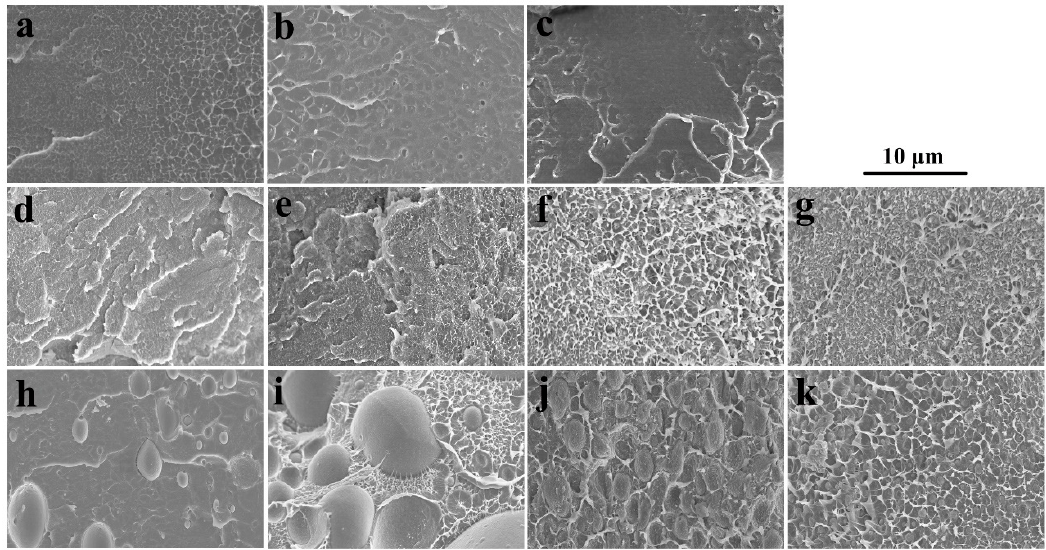
Figure 2. SEM images of ( a ) SPEEK44, ( b ) SPEEK73, ( c ) PVDF, ( d ) SPEEK44/PVDF-10, ( e ) SPEEK44/PVDF-30, ( f ) SPEEK44/PVDF-50, ( g ) SPEEK44/PVDF-80, ( h ) SPEEK73/PVDF-10, ( i ) SPEEK73/PVDF-30, ( j ) SPEEK73/PVDF-50 and ( k ) SPEEK73/PVDF-80 blend membranes.